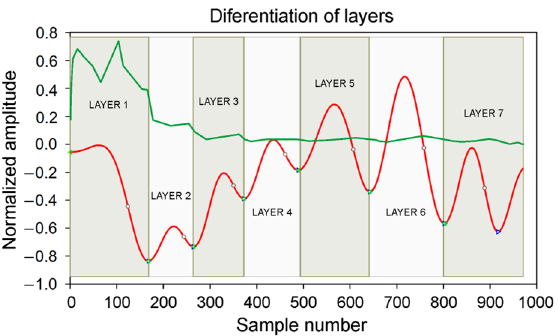
Figure 10. Joint representation of the envelope (green) with the smoothed steps (red). The ○ symbols indicate critical points showing the differentiation of layers.